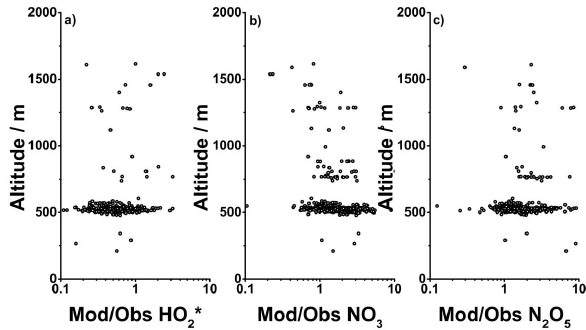
Figure 4: Modelled to observed ratios as a function of altitude for (a) HO 2 , (b) NO 3 and (c) N 2 O 5 . There are limited data above altitudes of 2000 m, and data above 2000 m are not shown for clarity.